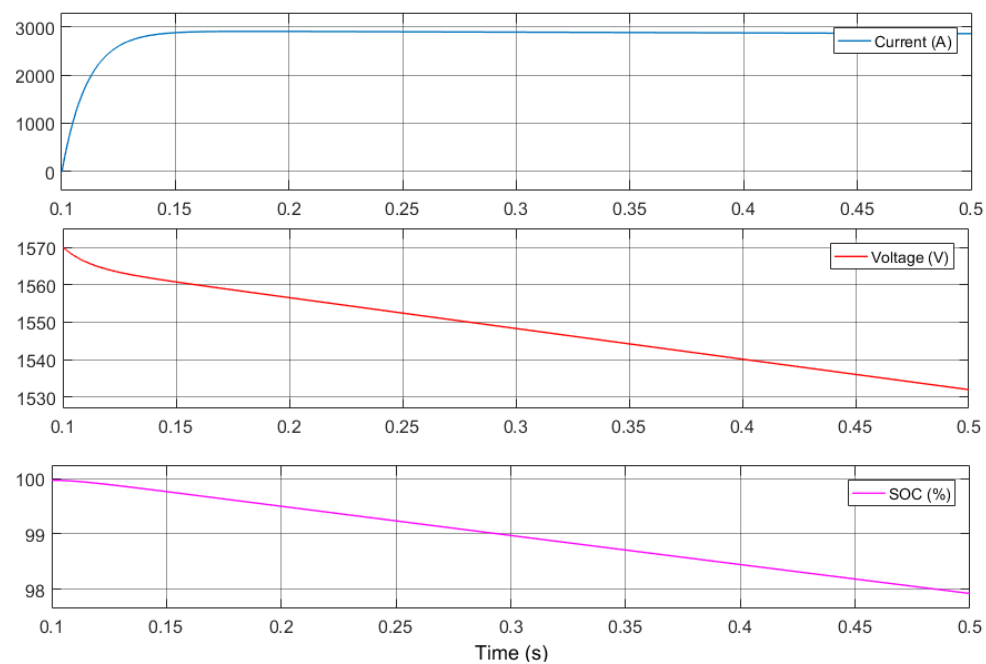
Figure 15. Simulation results WESD Scenario F2. Fault current (A), voltage (V), and SOC (%) vs. time (s).